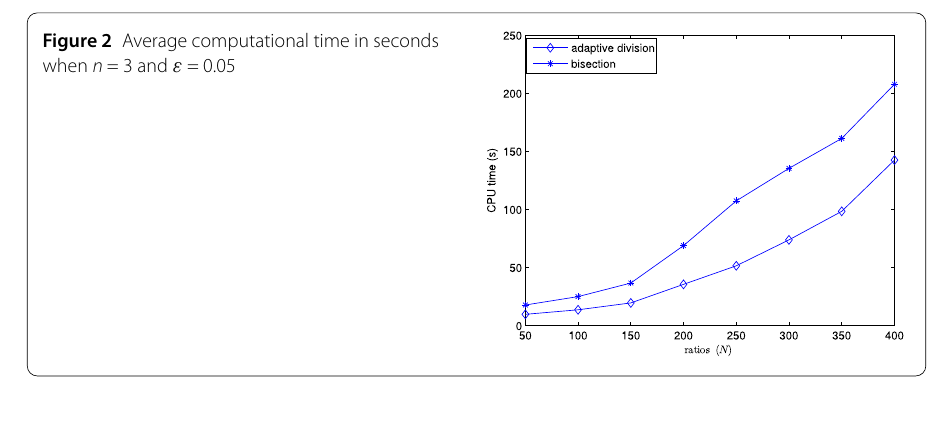
Figure 3 Average computational time in seconds when n = 3 and N =